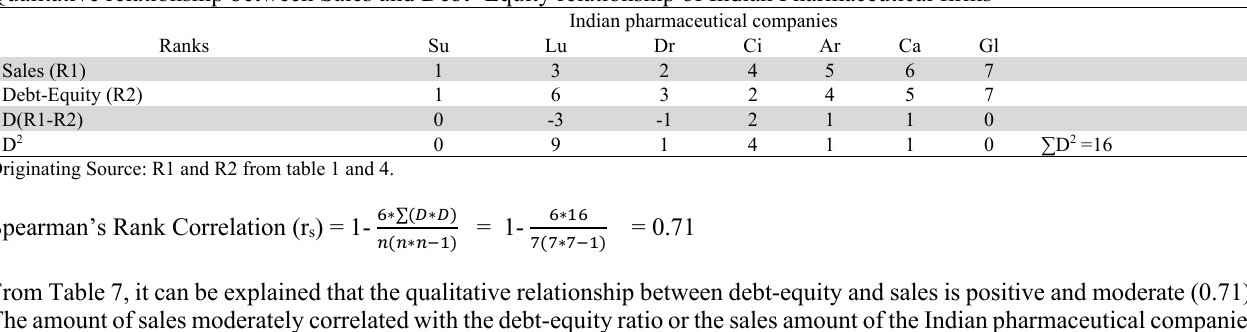
Qualitative relationship between Sales and Debt- Equity relationship of Indian Pharmaceutical firms Indian pharmaceutical companies Ranks Su